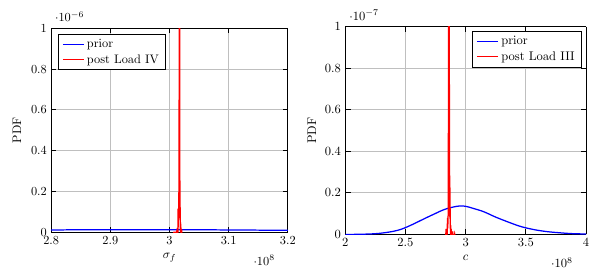
Fig. 10 Identification of inelastic parameters. Left: Failure stress 𝜎 f . Right: Drucker–Prager plasticity cohesion